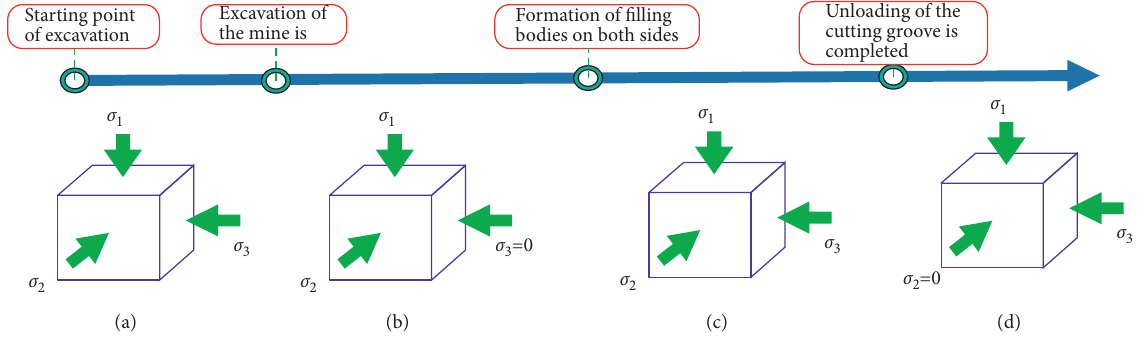
Figure 4: Stress variation of pillar at each stage of